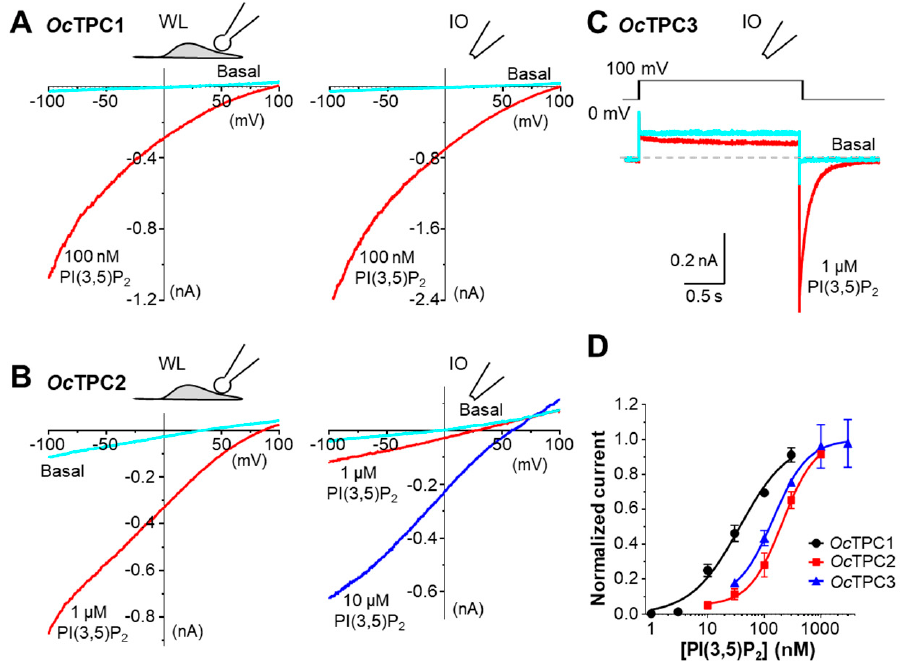
Figure 2. Rabbit TPC1, TPC2, and TPC3 are activated by PI(3,5)P 2 . HEK293 cells transiently transfected with cDNA coding for Oc TPC1-EGFP, Oc TPC2-EGFP, or Oc TPC3-EGFP as indicated were used for voltage-clamp recording using either whole-endolysosome (WL) or inside-out (IO) configurations. ( A , B ) Representative current–voltage (I–V) curves obtained from voltage ramps for WL ( left ) and IO ( right ) patches from cells that expressed Oc TPC1 ( A ) or Oc TPC2 ( B ). The patches were untreated (Basal) or exposed to PI(3,5)P 2 at the indicated concentrations in the bath. ( C ) Representative current traces detected in an IO patch excised from a cell that expressed Oc TPC3. The voltage was stepped from the holding potential at 0 mV to +100 mV for 2 s before returning to 0 mV. Dashed line indicates zero current. Note the large tail current in the presence of PI(3,5)P 2 ( red trace ) in the bath. The square response to +100 mV step under basal conditions ( cyan trace ) represents leak, unrelated to Oc TPC3 function. ( D ) Concentration–response curves to PI(3,5)P 2 for Oc TPC1, Oc TPC2, and Oc TPC3, determined using IO (for Oc TPC1 and Oc TPC3) and WL (for Oc TPC2) patches. Data are means ± SEM for n = 7 patches for each. Solid lines represent fit to the Hill equation. 3.2. The Cloned Rabbit TPC1, TPC2, and TPC3 Are Functional Ion Channels Sensitive to PI(3,5)P